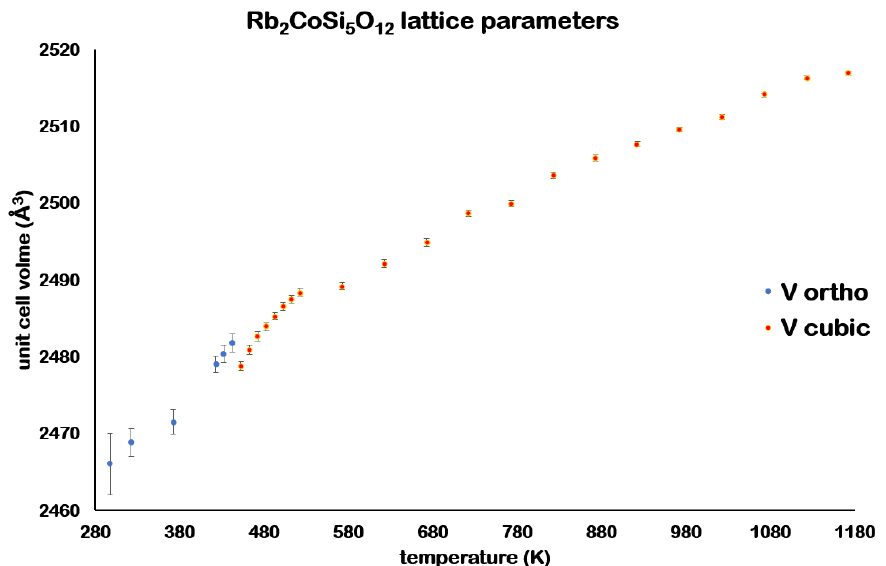
Figure 8. Variation of Pbca orthorhombic and Pa 3 cubic unit cell volumes with calibrated temperatures for Rb 2 CoSi 5 O l2 .